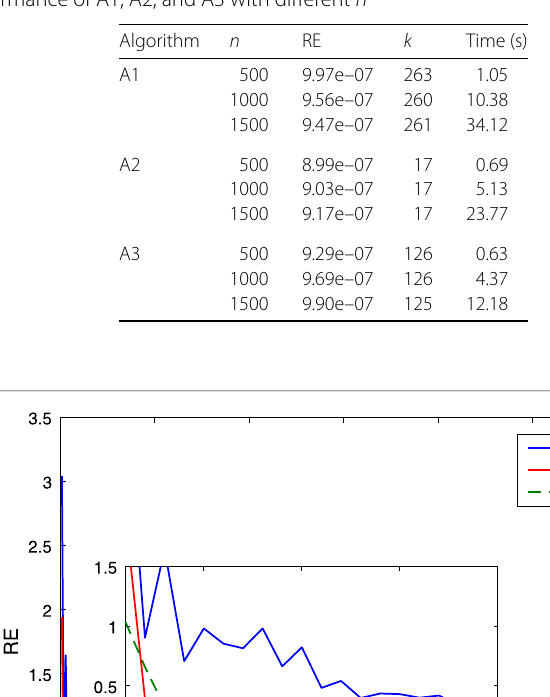
The stopping criterion is defined